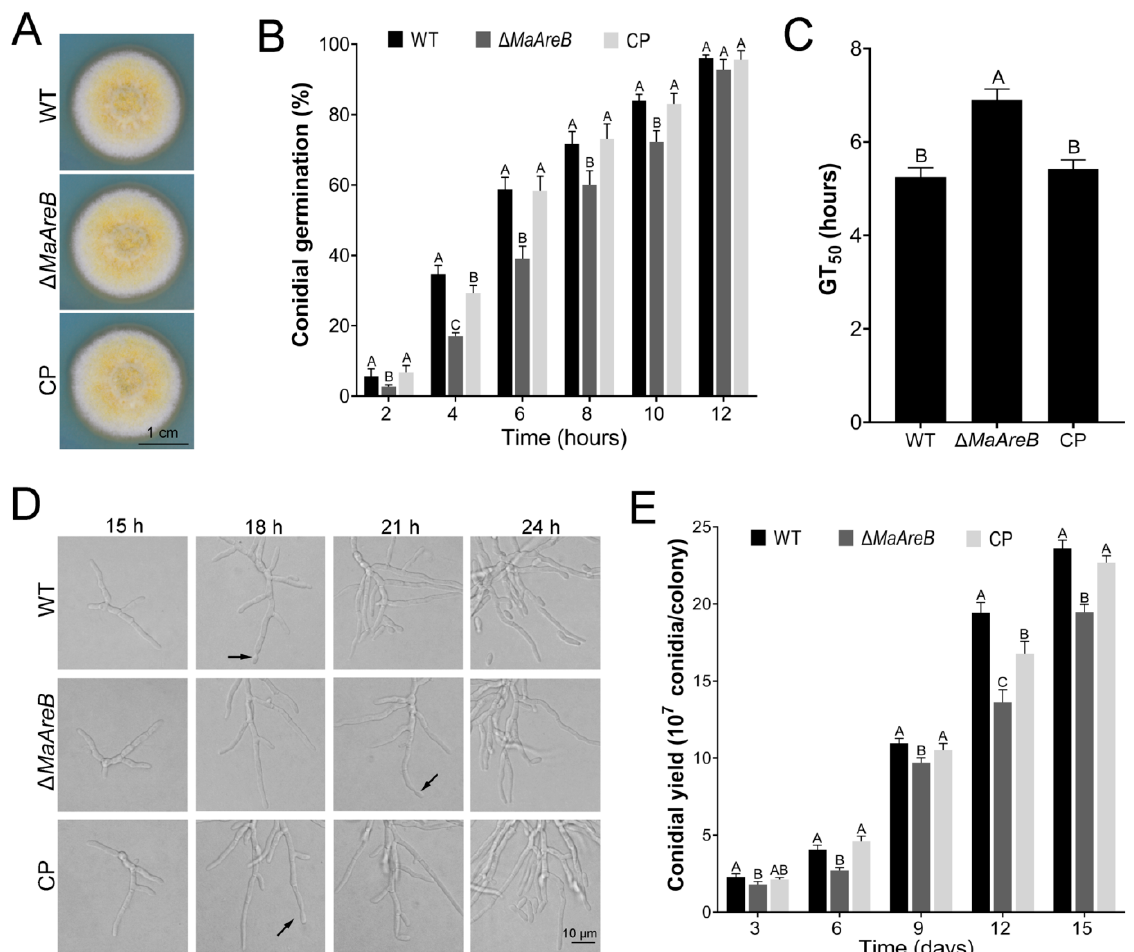
Figure 3. Deletion of MaAreB affected conidial germination, hyphal growth and conidiation. ( A ) Colonies of the WT, ∆ MaAreB and CP strains cultured at 28 °C for 7 days. ( B ) The germination rates of each strain at different time points. The GT 50 ( C ), microscopic observation of conidiation ( D ) and conidial yield ( E ) of each strain. All fungal strains were grown on 1/4SDAY. The arrows in Figure 3D indicated the conidium formed at the tip of the hypha. A & B, A & C and B & C, p < 0.05 (Tukey’s HSD). The p -values in Figure 3B, C and E are listed in supplementary Table S3.